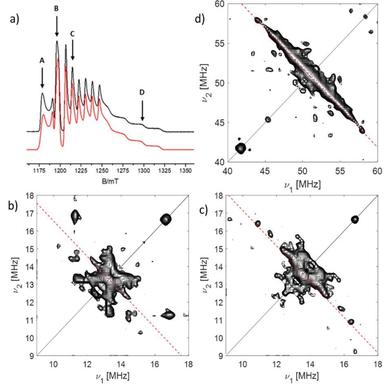
(a) Experimental (black) and simulated (red) Q-band Echo detected EPR spectrum of the V/ZSM5 sample. The spectrum was recorded at 10 K and s = 200 ns. The letters indicate the magnetic field settings at which 17O HYSCORE experiments were carried out; (b) Experimental 27Al Q-Band HYSCORE spectrum recorded at position B (B0 = 1196 mT) and s = 110 ns (c) 27Al Q-Band HYSCORE spectrum recorded at position C (B0 = 1222 mT) and s = 110 ns. The HYSCORE spectra were symmetrized; (d) 1 H Q-Band HYSCORE spectrum recor